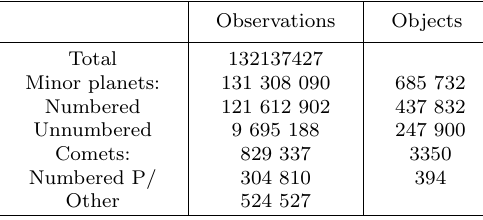
Table 1. The number of observation sessions and objects in the MPC’s catalogue as of June 2,